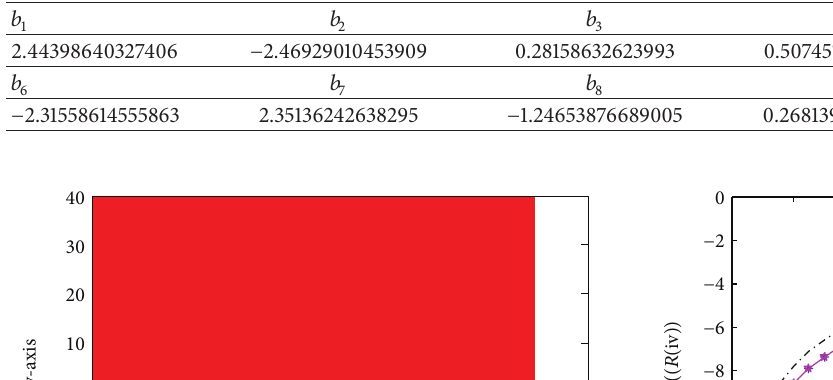
Table 2: The value of 𝑏 𝑖 ( 𝑖 = 1, 2, .. ., 9 ) and 𝐴 .